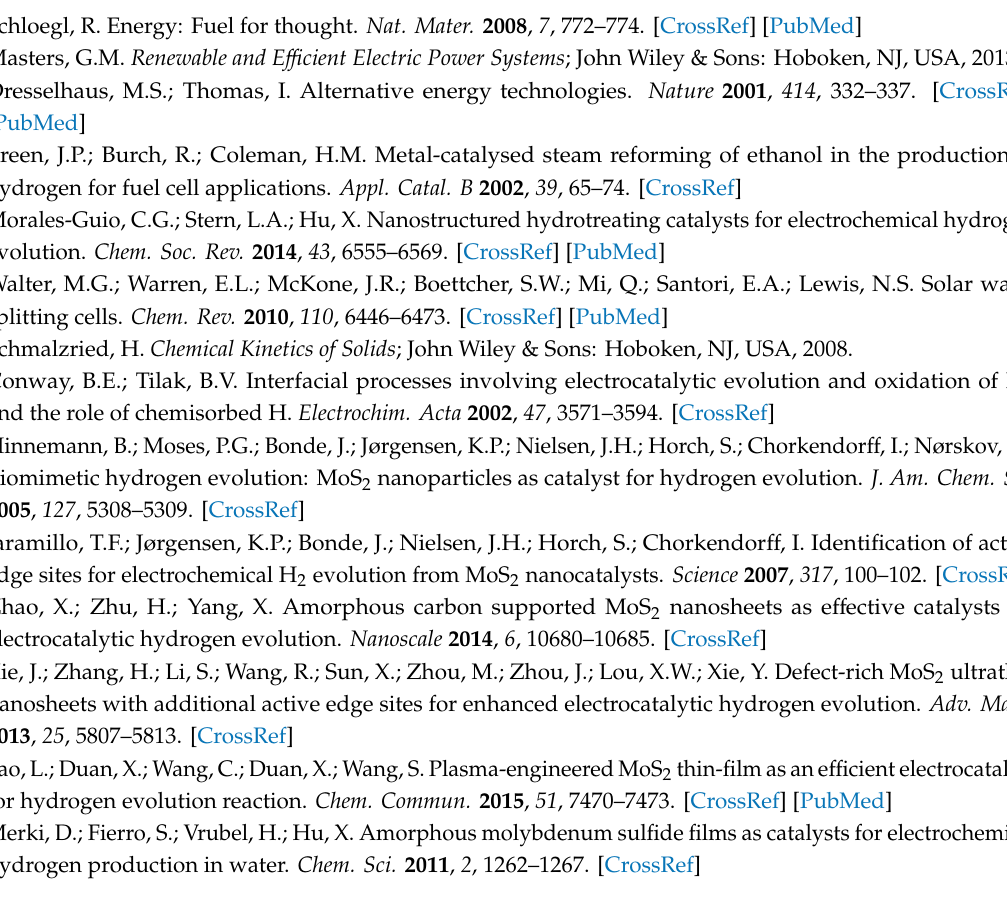
Figure S1. Schematic of the RF magnetron sputtering system, Figure S2. Thicknesses and morphologies of the Mo film and MoS 2 grown on the Si substrate, Figure S3. Cross-sectional HRTEM image of MoS 2 synthesized on the Si substrate and elemental line profile of MoS 2 corresponding to the white line. Author Contributions: Conceptualization, N.L. and S.K.; methodology, N.L. and J.K.; formal analysis,